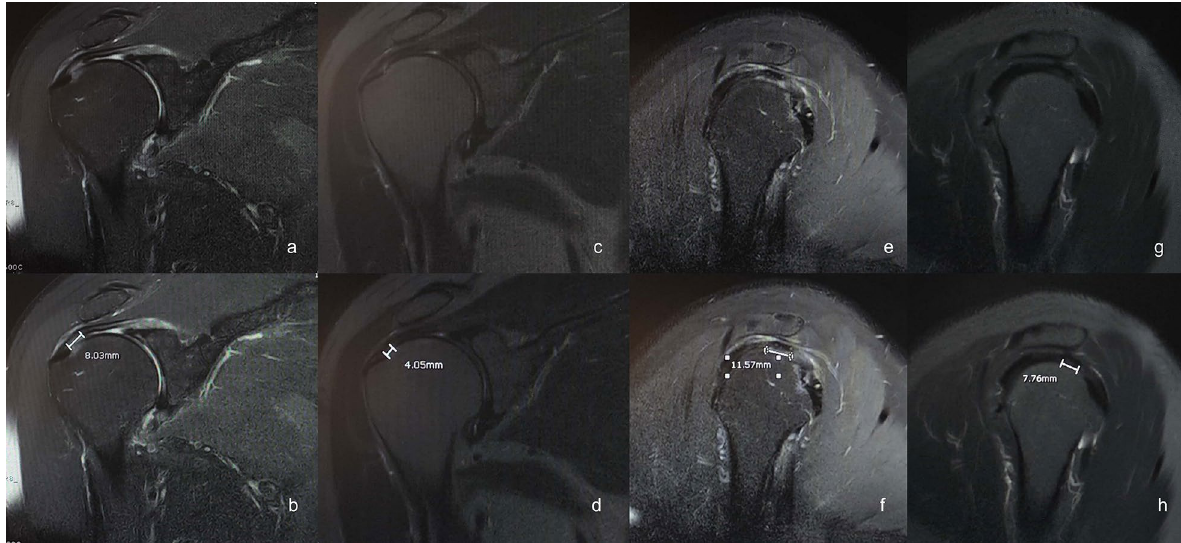
Fig. 2 A coronal oblique MRI image of the right supraspinatus tendon tear ( a ) with measurement ( b ) before the injection. A coronal oblique MRI image of the right supraspinatus tendon tear 6 months after the injection ( c ) with measurement ( d ). A sagittal oblique MRI image of the right supraspinatus tendon tear ( e ) with measurement ( f ) before the injection. A sagittal oblique MRI image of the right supraspinatus tendon tear 6 months after the injection ( g ) with measurement ( h